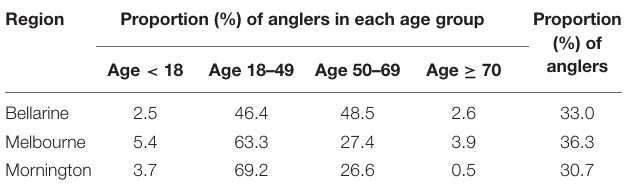
TABLE 1 | Fishing area and the proportion of anglers surveyed as well as the proportion of anglers in age groups for each fishing area based on 6,035 fishing trip records in Port Phillip Bay (Victoria) from 2010/2011 to 2018/19. Region Proportion (%) of anglers in each age group Proportion